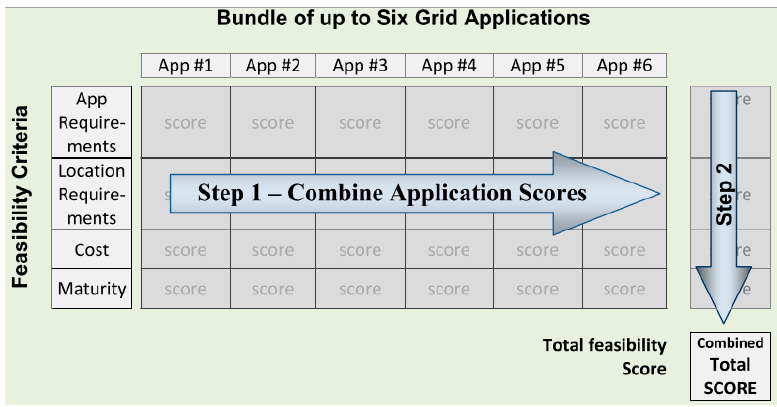
Figure 4. Computation process for the total feasibility score of each storage option after KEMA [7].